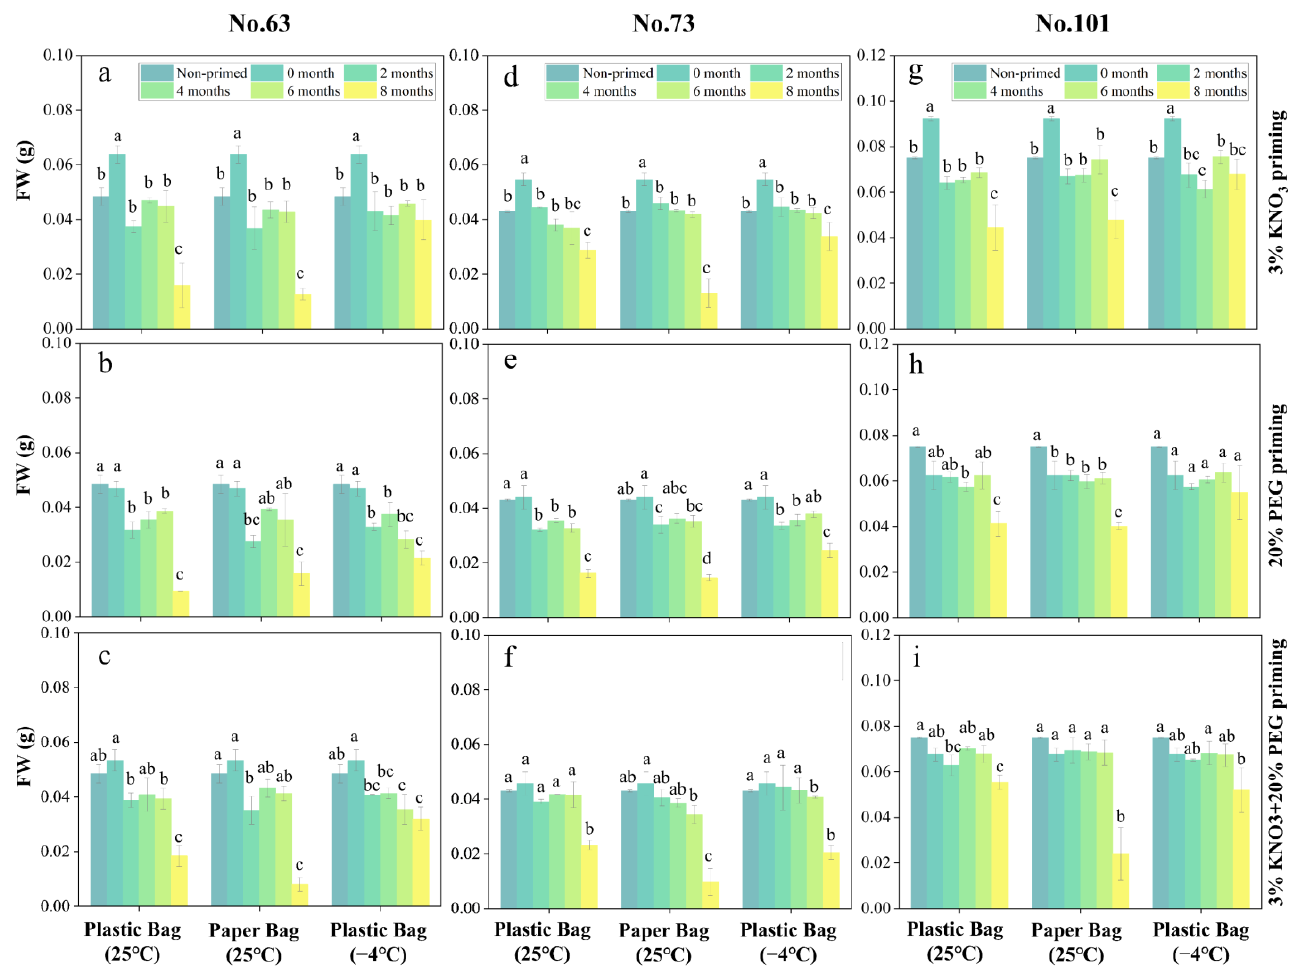
Figure 5. Average fresh weight of seedlings from primed pepper seeds under different storage conditions. FW: fresh weight. ( a – c ) the fresh weight for No.63 pepper seeds; ( d – f ) the fresh weight for No.73 pepper seeds; ( g – i ) the fresh weight for No.101 pepper seeds. ( a , d , g ) 3% KNO 3 priming; ( b , e , h ) 20% PEG priming; ( c , f , i ) 3% KNO 3 + 20% PEG priming. Different letters in the same cultivar for each treatment denote the difference between the storage duration of a storage condition at the 5%